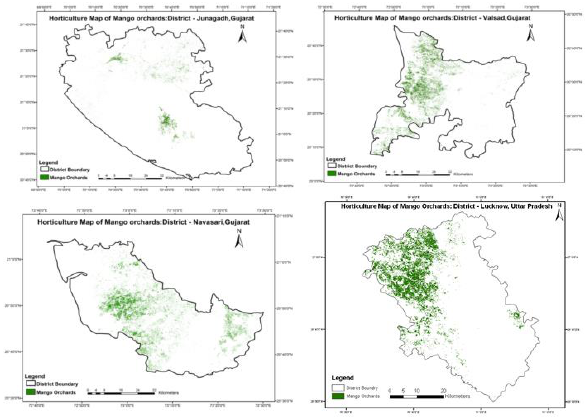
Figure 5. Classified Mango orchards for districts of Gujarat and Uttar Pradesh 3.2 Banana